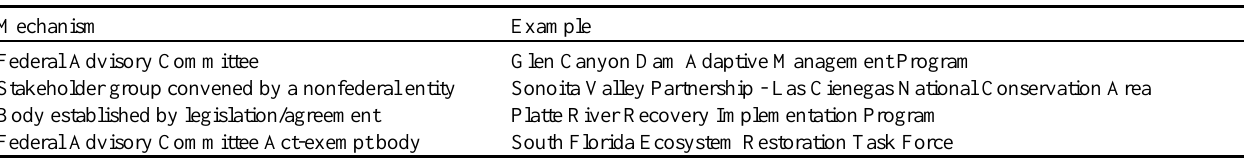
Table 1 . Mechanisms for multistakeholder collaboration and examples of adaptive management programs using each